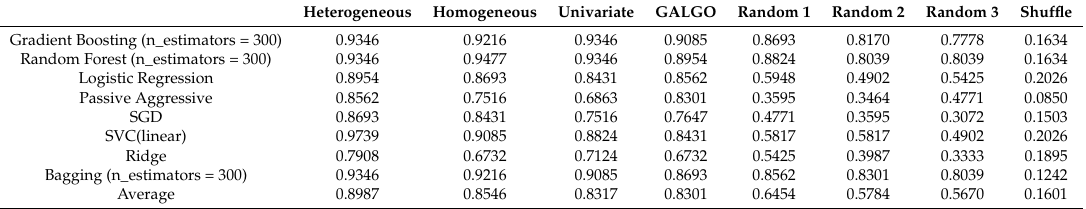
Table 4. Matthews correlation coefficient values for the 10% data left for testing the feature selection algorithm: The results for the heterogenous recursive ensemble feature selection algorithm, the homogeneous recursive ensemble feature selection algorithm, K-Best feature selection algorithm using f-score as selection citeria, 3 random feature subsets and a random shuffle of the test